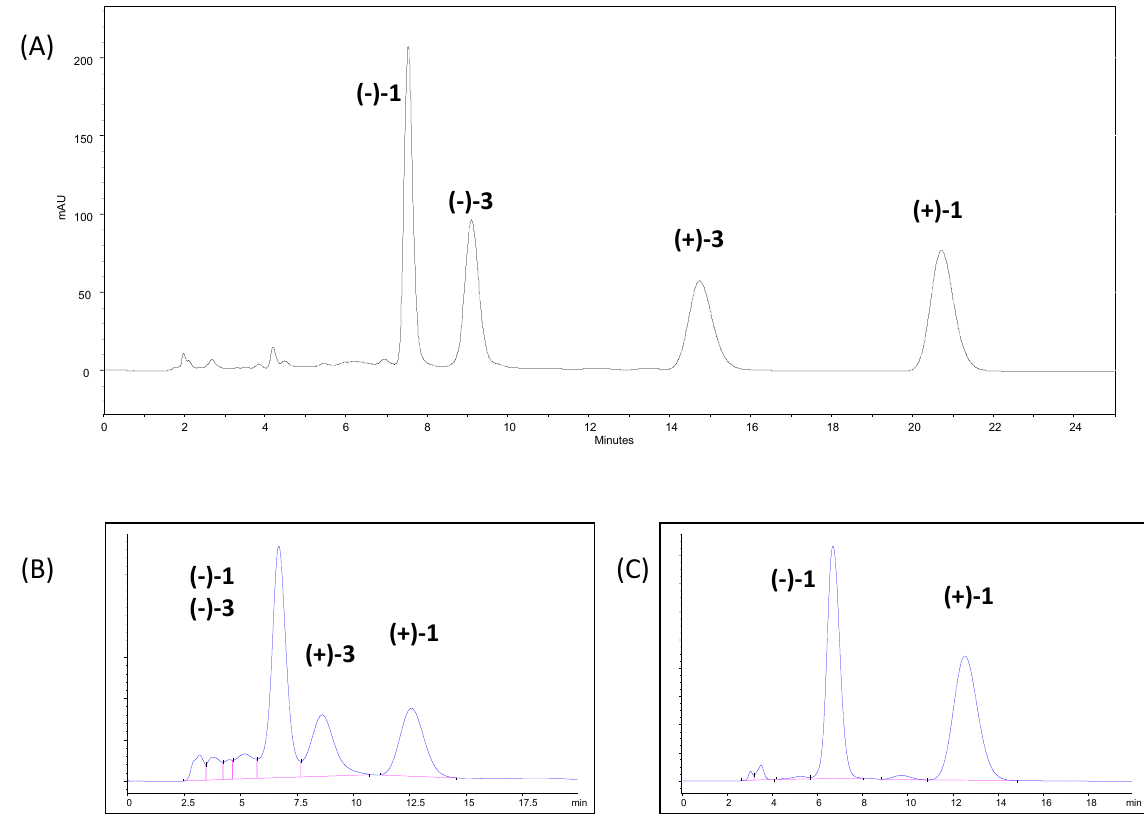
Figure 1. Chromatographic separation by HPLC of ( A ) crude mixture of racemic 1 and 3 on CHIRALPAK IC (5 µm, 250 × 4.6 mm) in n -heptane/DCM/EtOH/DEA 50:50:1:0.1, 2 mL/min, 25 °C; ( B ) crude mixture of racemic 1 and 3 on CHIRALPAK IC (20 µm, 250 × 4.6 mm) in DCM/i-PrOH/DEA 95:5:0.1, 1 mL/min, 25 °C; ( C ) Racemic 1